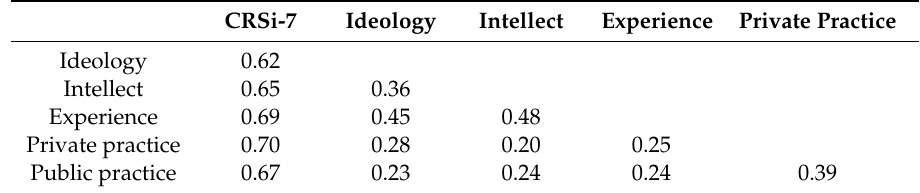
Table 5. Correlations of the core dimensions of the CRSi-7 in the Christian orthodox sample in the year 2018. CRSi-7 Ideology Intellect Experience Private Practice